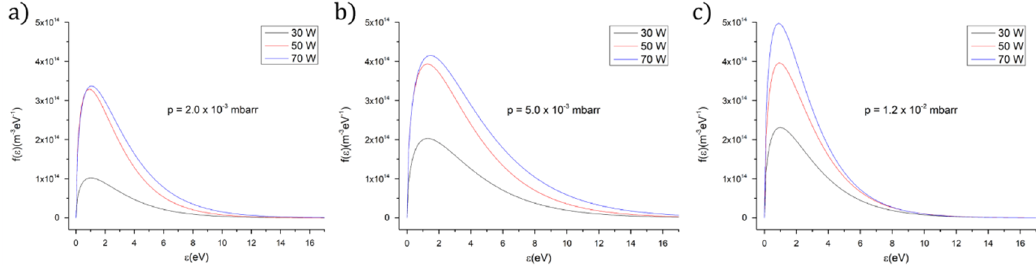
Figure 1. Dependence of electron energy distribution function on applied radio frequency (rf) power for: ( a ) p = 2 × 10 −3 mbarr; ( b ) p = 5 × 10 −3 mbarr; ( c ) p = 1.2 × 10 −2 mbarr.